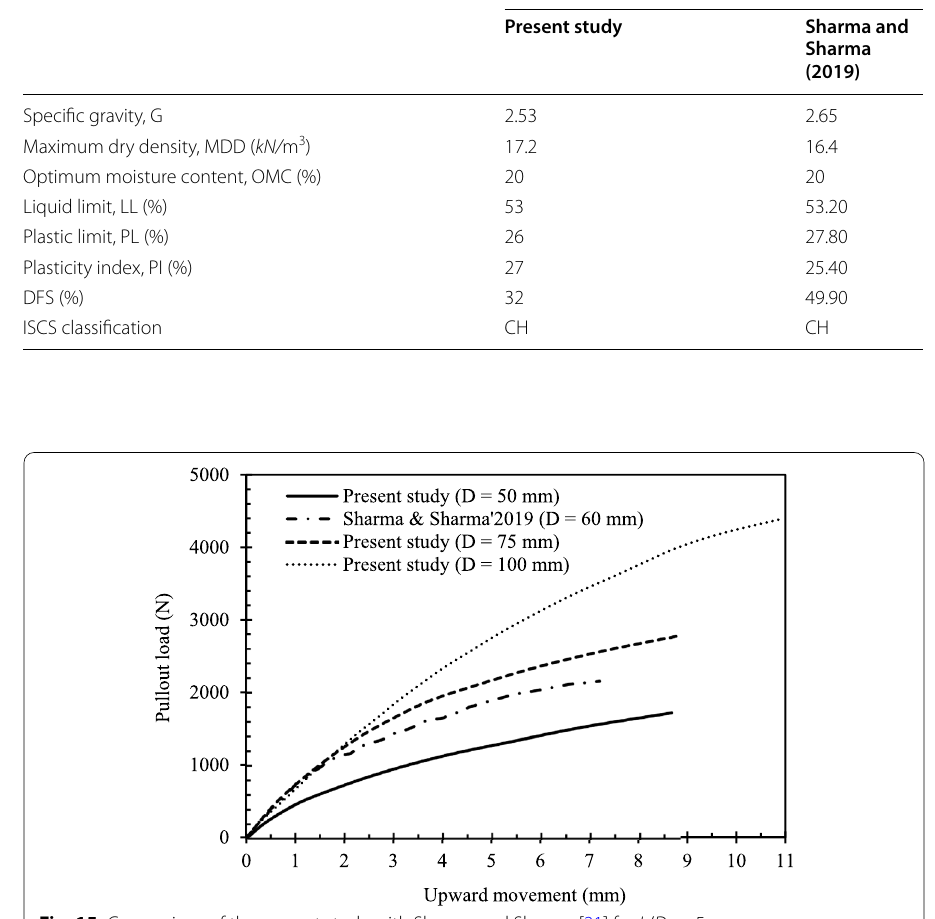
Fig. 15 Comparison of the present study with Sharma and Sharma [21] for L / D